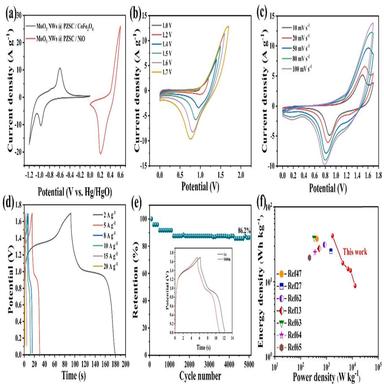
(a) CV curves of both MoO3 @ PZSC / NiO (+) and MoO3 @ PZSC / CoFe2O4 (-) electrodes at 10 mV s−1. (b) CV curves at 100 mV s−1 of the assembled MoO3 @ PZSC / NiO (+) //MoO3 @ PZSC / CoFe2O4 (-) cell. (c) CV curves of the MoO3 @ PZSC / NiO (+) //MoO3 @ PZSC / CoFe2O4 (-) cell at different sweep speed. (d) GCD curves at 2–20 A g−1 of MoO3 @ PZSC / NiO (+) //MoO3 @ PZSC / CoFe2O4 (-). (e) Cycling stability of MoO3 @ PZSC / NiO (+) //MoO3 @ PZSC / CoFe2O4 (-), and the inserted GCD curves for the first and the 5